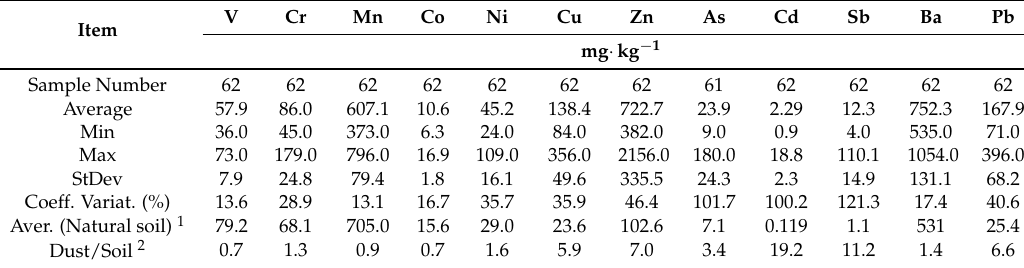
Table 2. Descriptive statistics for concentrations of potentially toxic elements in settled dust in the Beijing urban area. Additionally, the average concentrations of these elements in natural soil in Beijing City are also